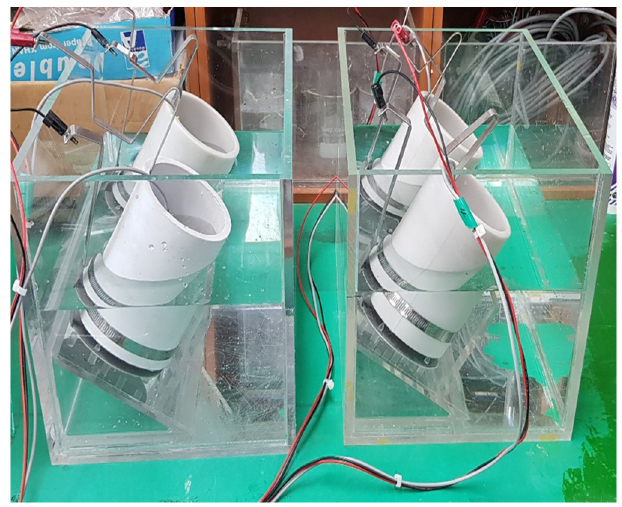
Figure 4. NT Build 492 measurement test equipment.